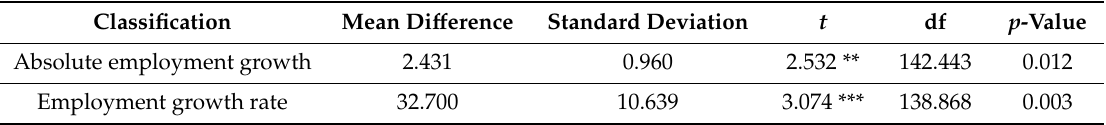
Table 10. T-test for employment